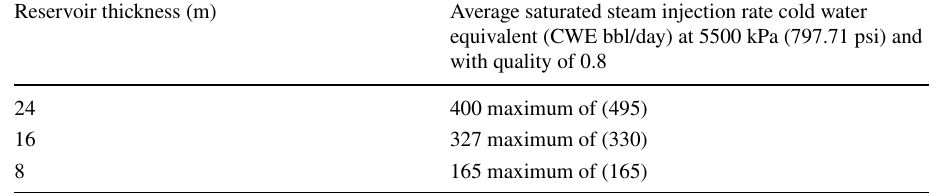
Table 5 Average steam injection rate for the PIHC